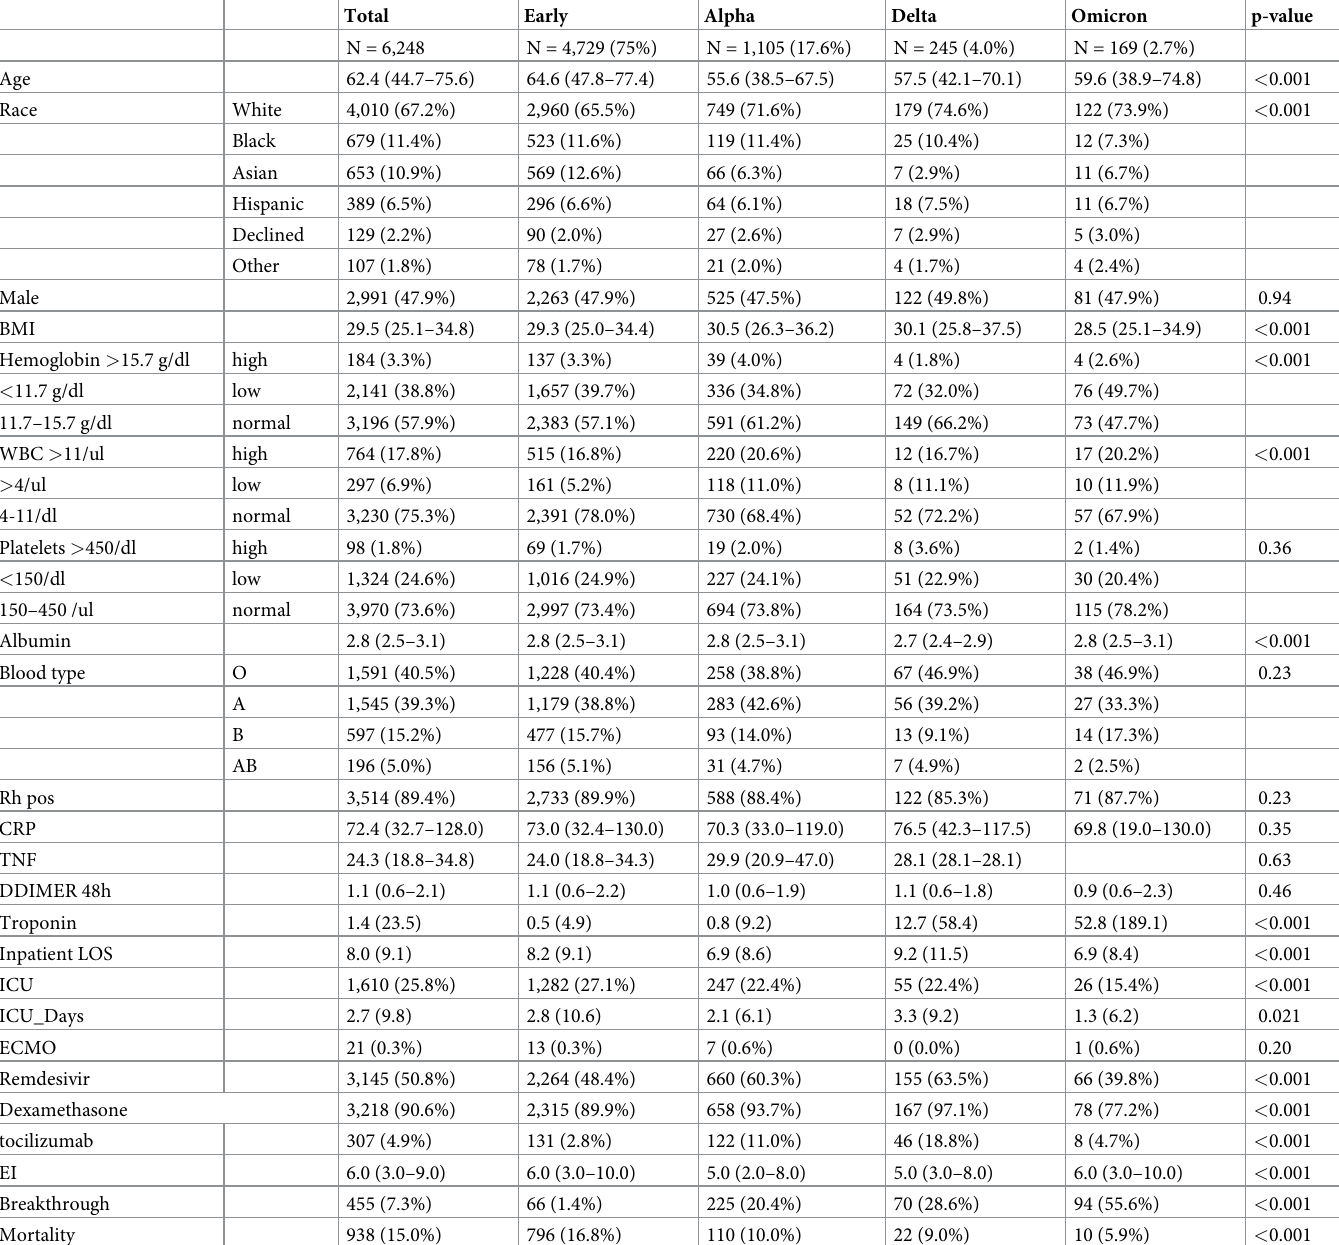
Table 2. Descriptive Table of characteristics and demographics of COVID-19 inpatient based on variants. Categorical variables expressed as count and percentage, and continuous variables as median and